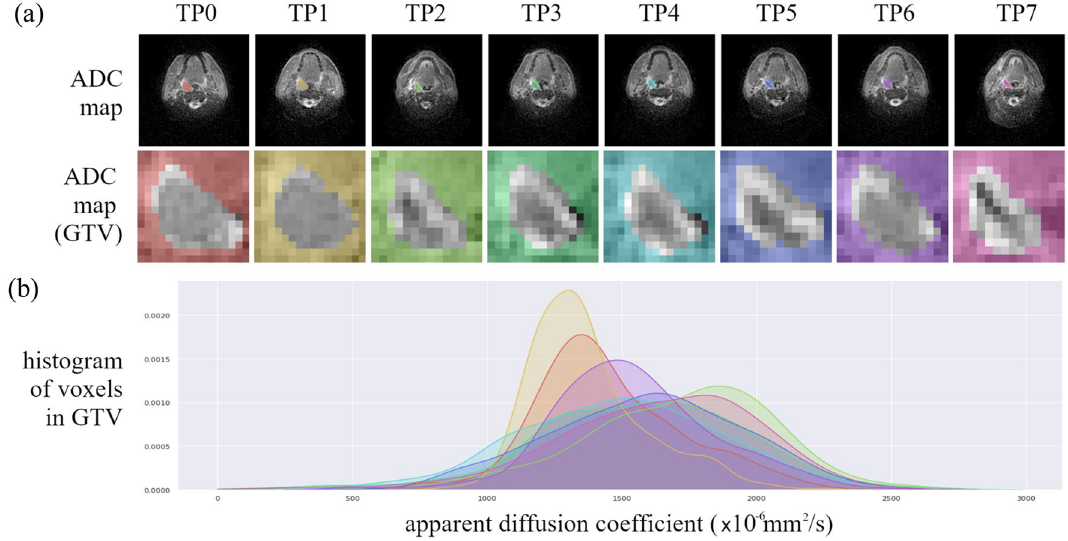
Figure 1. Apparent diffusion coefficient (ADC) maps of a head and neck cancer patient throughout radiotherapy from the PREDICT-HN prospective clinical trial. ( a ) ADC maps are displayed with (top row) the gross tumour volume (GTV) highlighted in colour and (middle row) cropped to the GTV to focus on the region of interest for the radiomic analysis. Change in ( b ) the ADC histogram within the GTV is from baseline (TP0), weekly throughout radiotherapy (TP1–TP6) and post-radiotherapy (TP7) with the histogram colour matched to the GTV contour